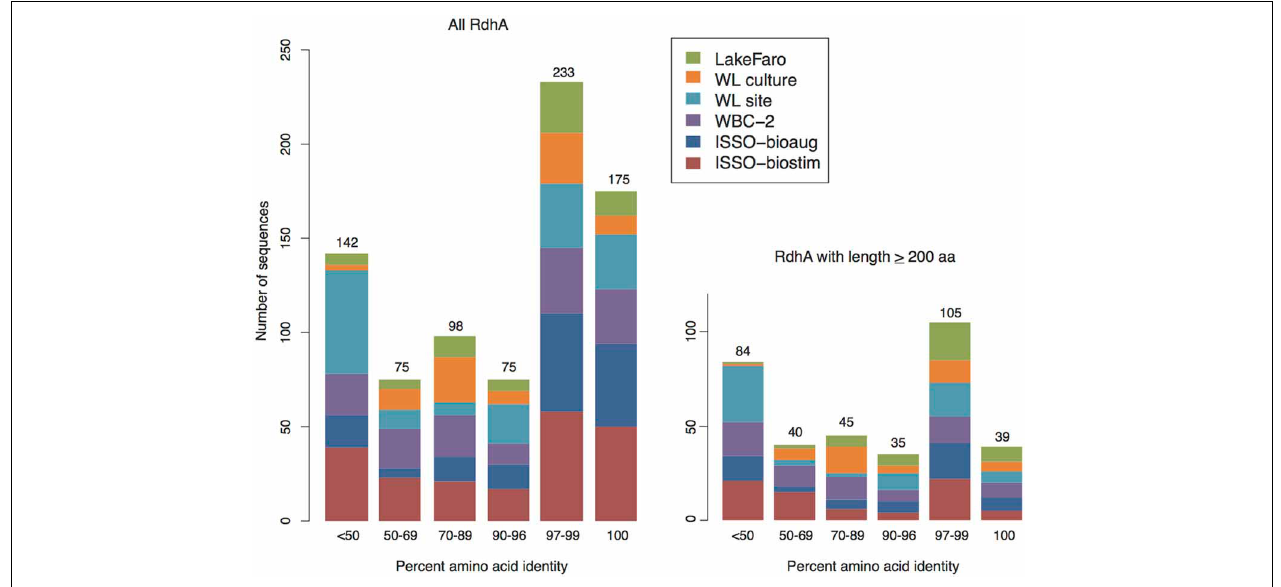
FIGURE 4 | Newly sequenced RdhA proteins are split between close homologs to known sequences and novel sequences. Barcharts of percent amino acid identity between the newly-sequenced RdhAs and the most closely related RdhA from available protein databases (translated in-house curated rdhA database as well as NCBI Protein non-redundant